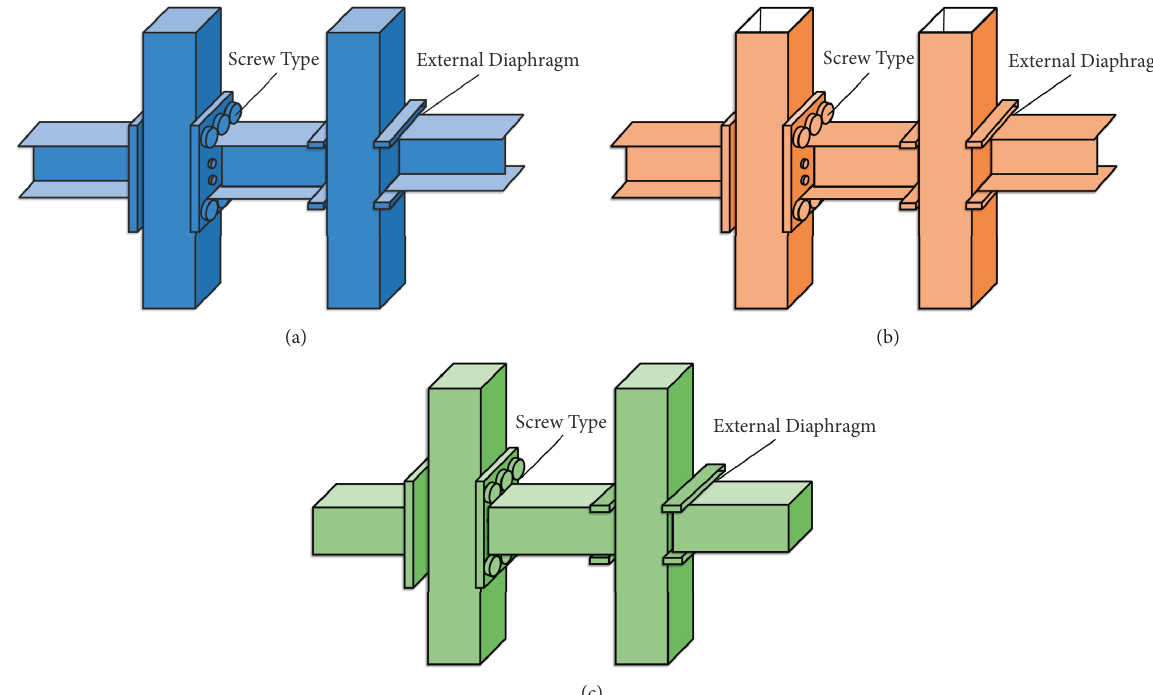
Figure 3: Model diagrams of six types of simulated combination modes: (a) steel tube column and steel beams; (b) CFSTcolumns and steel beams; (c) CFST columns and